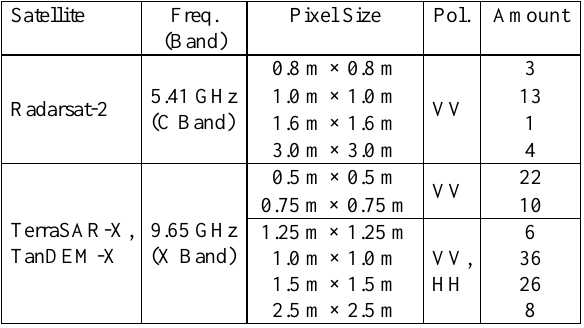
Table 1. SAR systems parameters and used SAR